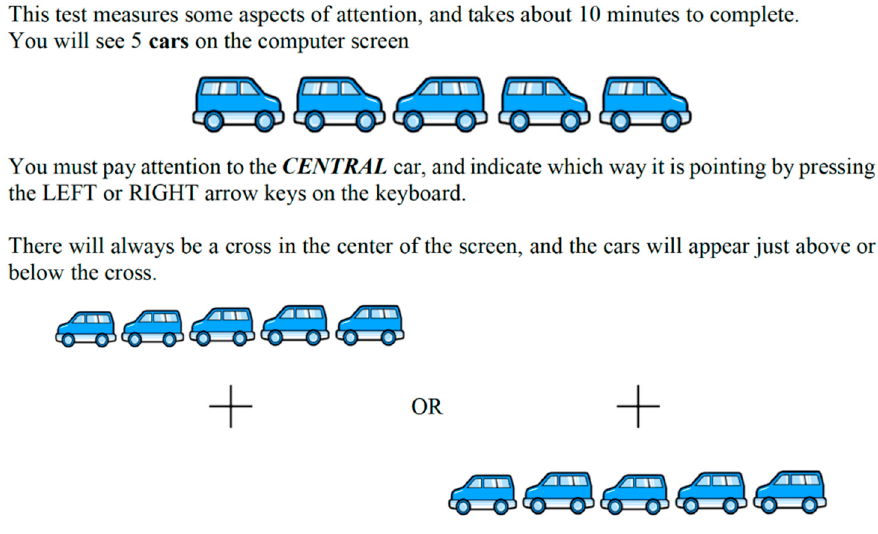
Figure 1. Typical instruction and typical screen scene to solve the cognitive task.